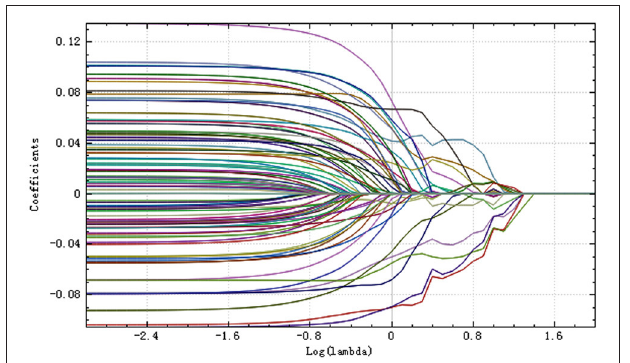
FIGURE 3 | Plot of coefficients-lambda.